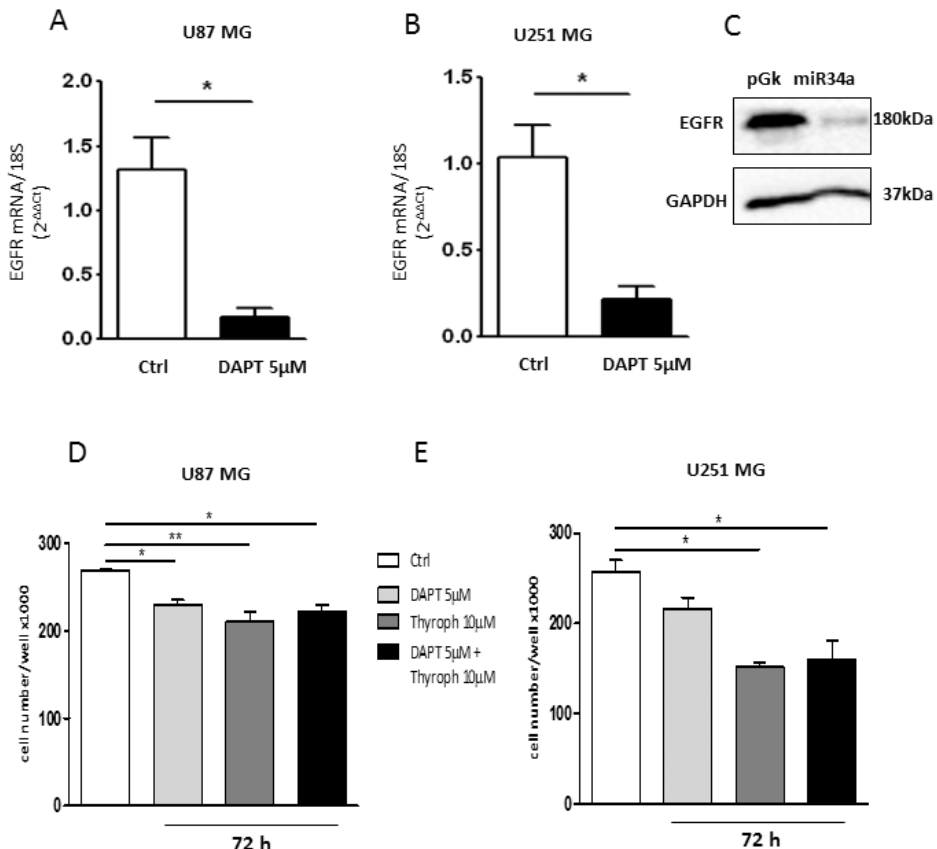
Figure 7. Effect of Notch/EGFR inhibition on GBM cell growth. Real time RT-PCR analysis of EGFR expression in U87MG ( A ) and U251MG ( B ) cells treated with 5 µ M DAPT for 24 h; ( C ) Western blot analysis for EGFR in U87MG cells transfected with mir-34a-5p. GAPDH was used as the internal reference protein (* p < 0.05; t -test); ( D , E ). Analysis of the cell growth in U87MG and U251MG cells, respectively, treated with 5 µ M DAPT, or 10 µ M Tyrph or 5 µ M DAPT plus 10 µ M Tyrph (* p < 0.05; ** p < 0.01; t -test and one-way ANOVA